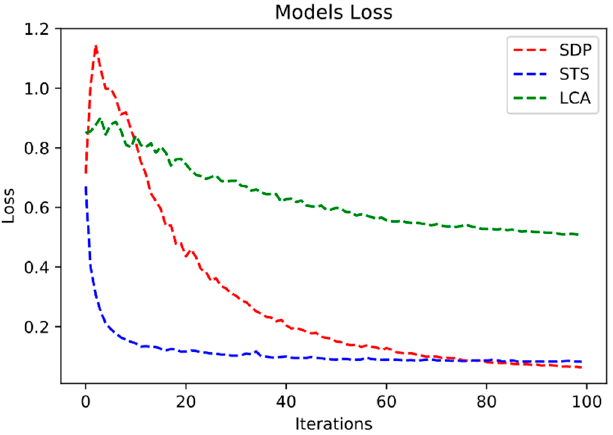
Figure 7. RE models’ loss per epoch.